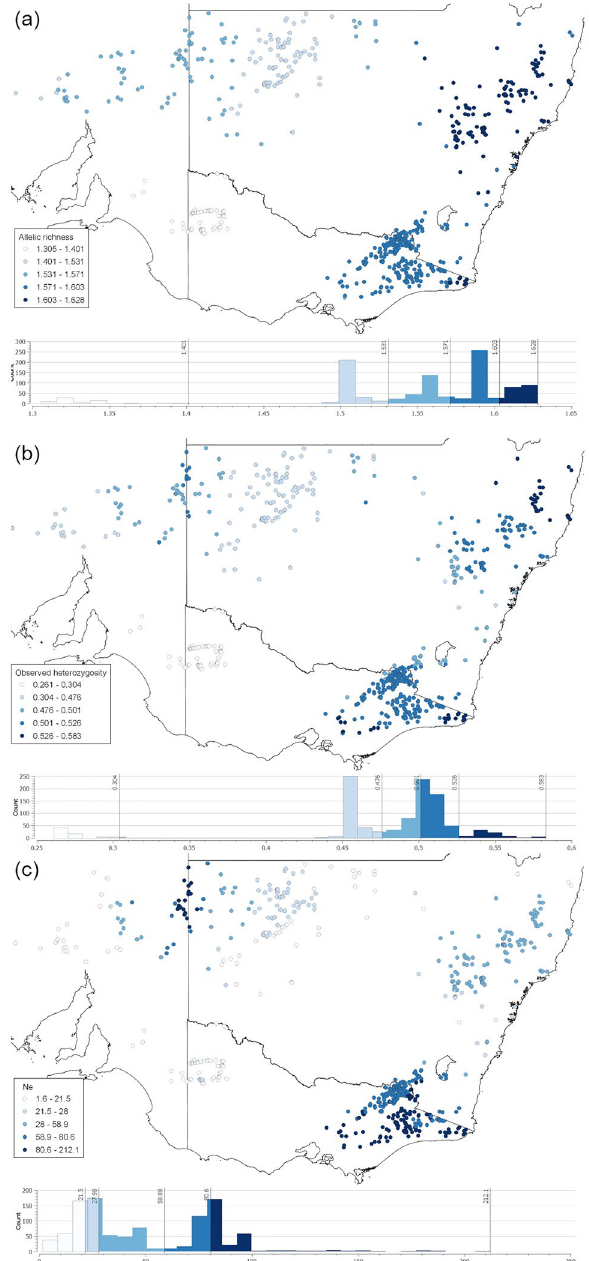
Figure 3. sGD values for each individual plus individuals in the surrounding 200 km. Individuals with fewer than 10 surrounding points within 200 km are not shown. ( a ) Allelic richness values, graded from lightest blue for low values to dark blue for higher values using five Jenks natural breaks, calculated and mapped using QGIS V3.22.3 (http:// www. qgis. org). Histogram of allelic richness values distribution from QGIS is shown below the map; vertical lines indicate the values of the Jenks breaks. ( b ) As for ( a ), showing observed heterozygosity. ( c ) As for ( a ), showing effective population size calculated using alleles with frequency >